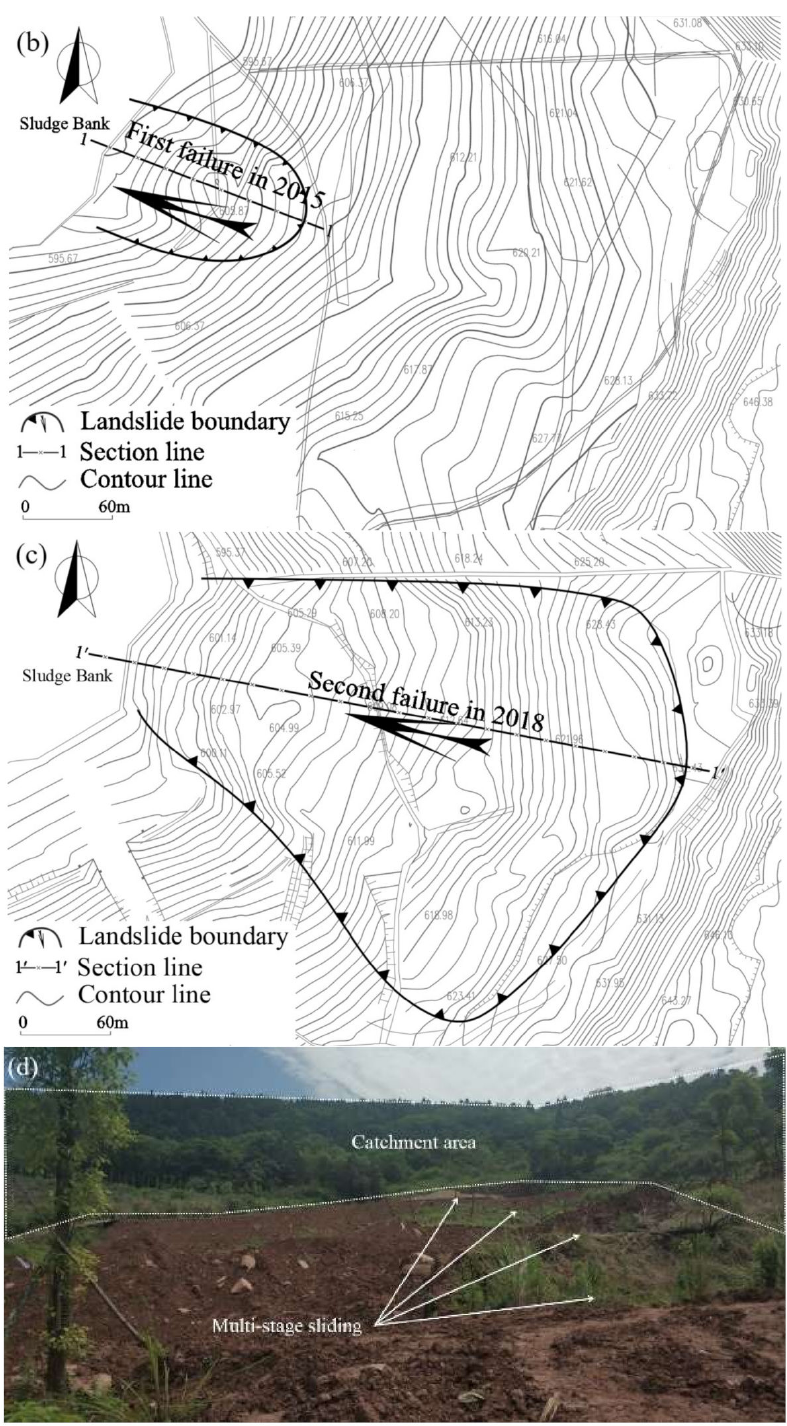
Figure 1. ( a ) Location of the study area; ( b ) first failure in 2015; ( c ) second failure in 2018; and ( d ) photograph of the Yingtaogou